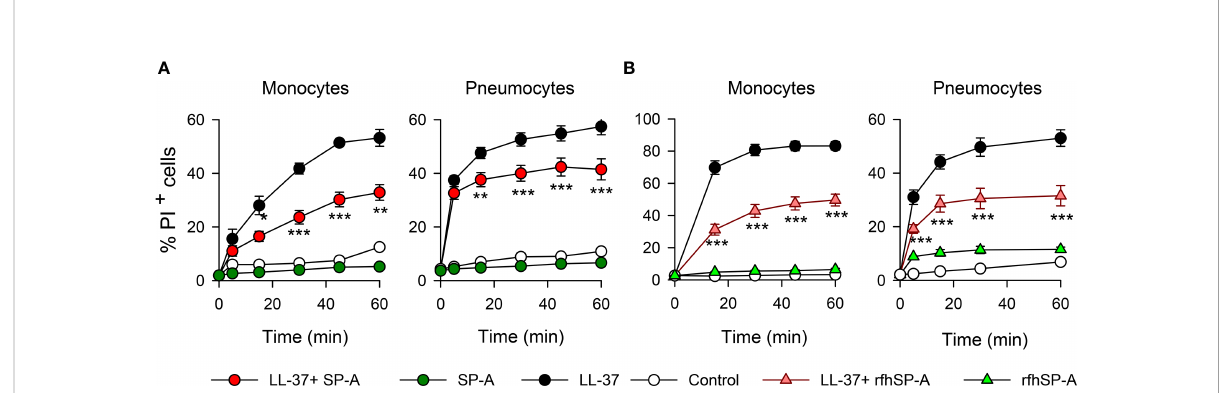
FIGURE 10 SP-A and rfhSP-A signi fi cantly reduce LL-37-induced uptake of propidium iodide by pneumocytes and monocytes. Kinetics of PI incorporation in human monocytes (U937) and pneumocytes (A549) were determined by fl ow cytometry. Cells were exposed to LL-37 (2.5 µM) in the presence and absence of (A) SP-A (0.15 µM) or (B) rfhSP-A (0.88 µM) at 37°C. Results are means ± S.E.M. of three different cell cultures, with three biological replicates. For statistical analysis, ANOVA followed by Bonferroni multiple comparison test was used. **p < 0.01, ***p < 0.001, when cells treated with LL-37+SP-A or LL-37+rfhSP-A complexes are compared with cells treated with LL-37